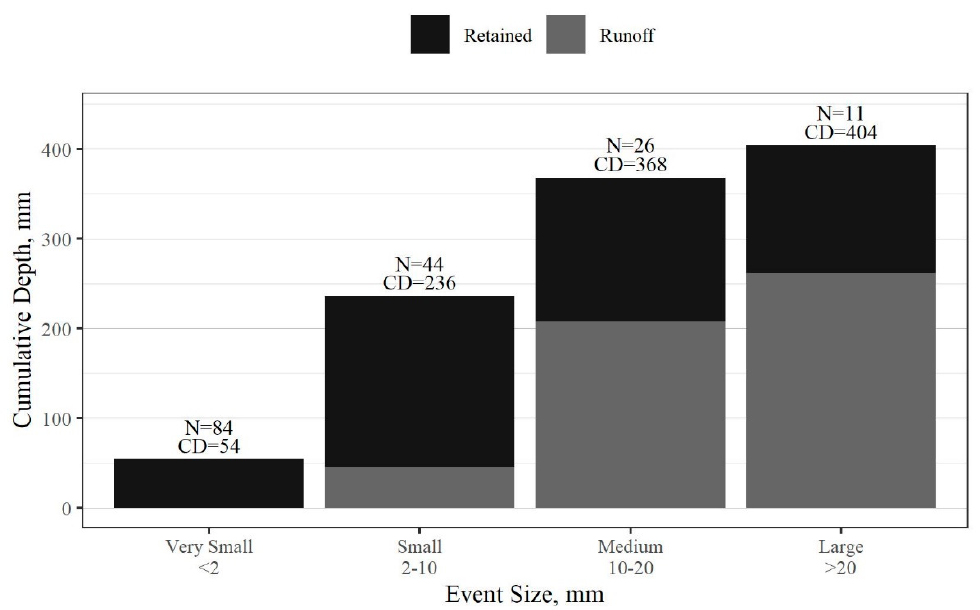
Figure 6. Runoff and retention from the OnCenter green roof, designed to hold a 25.4 mm rainfall event, grouped by event size. Cumulative depth (CD) is the sum of runoff and retained depth. Total rainfall over the 21-month study period, excluding snow days, is the sum of cumulative depths in each range—1062 mm in total. Table 2. Details for 11 events which exceed 20 mm in total depth. Retention depth is calculated as the difference between rainfall and runoff depth. Initial soil moisture is the average of the four sensors for the timestep preceding the onset of rain.